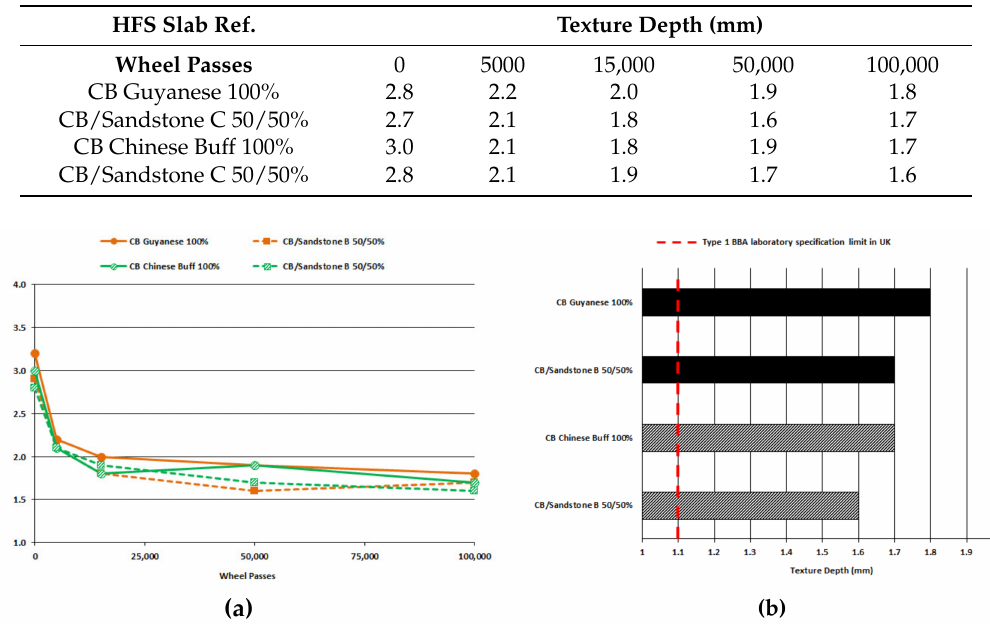
Figure 11. ( a ) Texture depth development up to 100,000 wheel-passes; ( b ) texture depth ranking after 100,000 wheel-passes (Ulster University